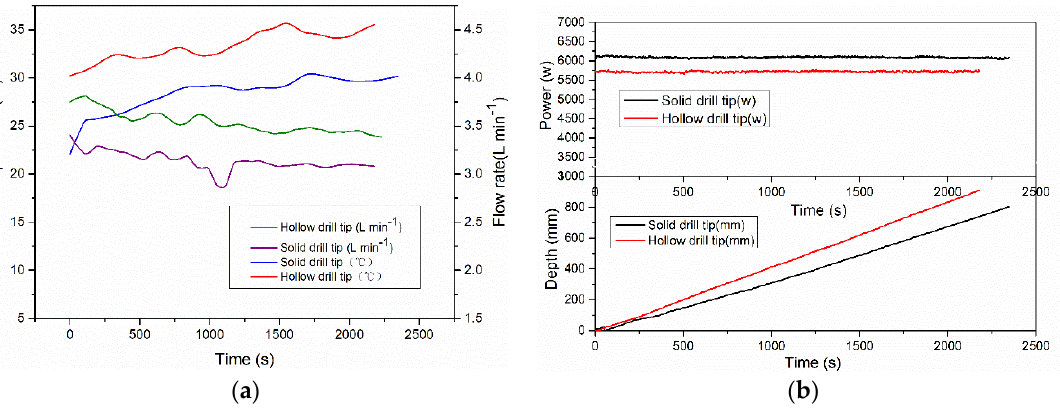
Figure 14. Results of comparison testing of the hollow drill tip and the solid drill tip: ( a ) outlet tem- perature and flow rate vs. time; ( b ) penetration depth and power vs. time. temperature and flow rate vs. time; ( b ) penetration depth and power vs.